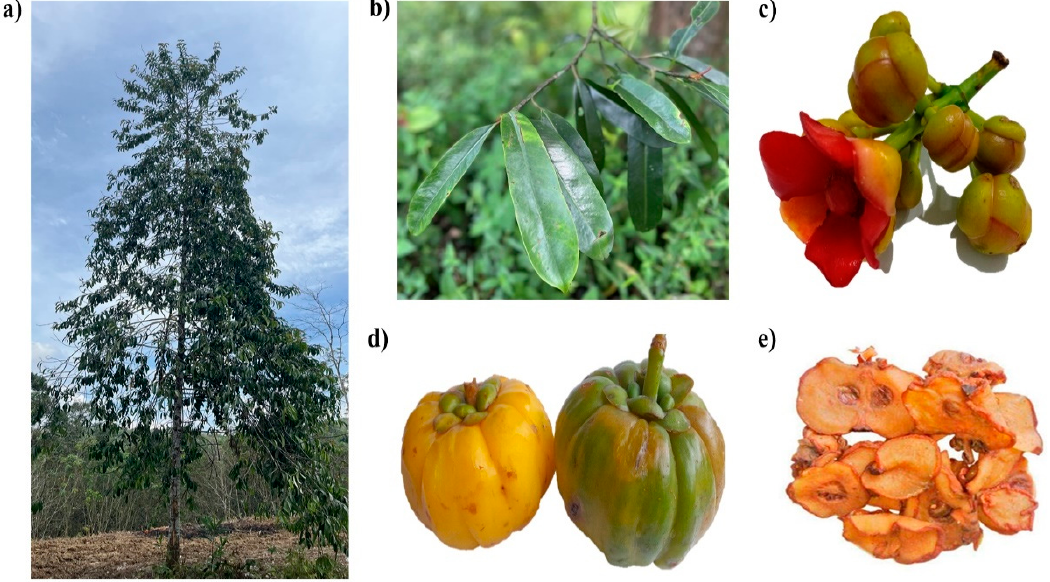
Figure 2. Different parts of G. atroviridis . ( a ) The G. atroviridis tree, ( b ) leaves, ( c ) flower, ( d ) ripened (yellow) and non-ripened (green) fruits, and ( e ) dried fruit slices (Asam Keping) from G. atroviridis.